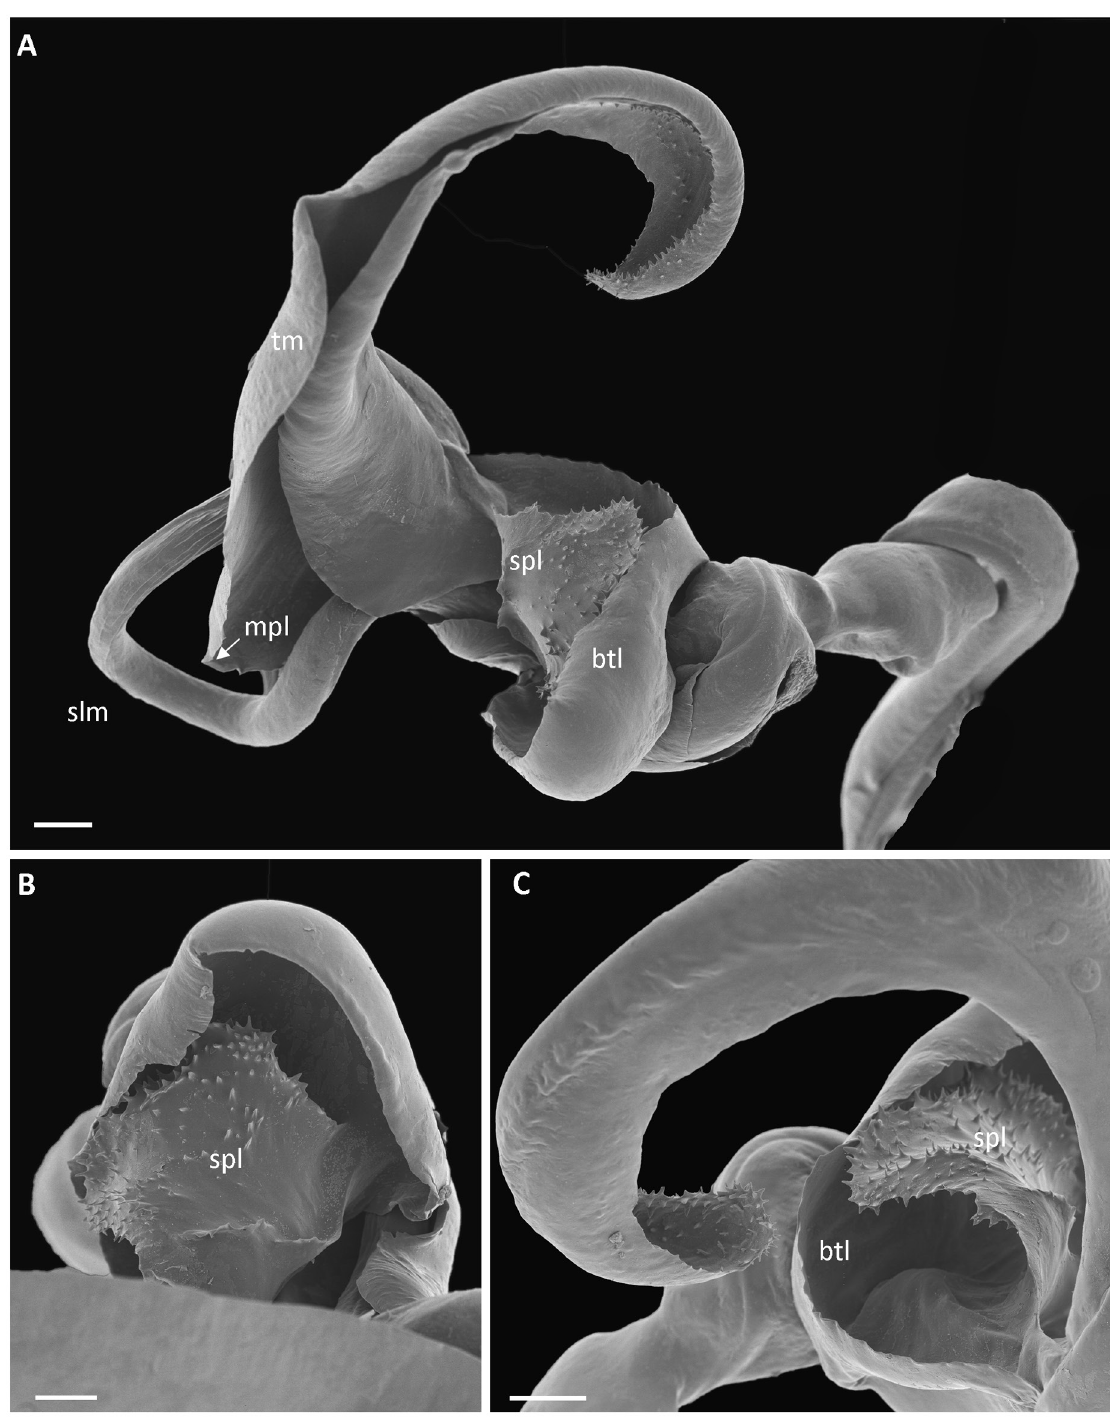
Fig. 17. Aquattuor udzungwensis Enghoff, 2015, male from Udzungwa Mts National Park, Kidatu (NHMD 621659), left gonopod telopodite. A . (Meso-)posterior view. B . Basal telomeral lamella, distal (ventral) view. C . Telomere, sublateral view. Abbreviations: btl = basal telomeral lamella; mpl = meso- posterior telomeral lamella, the arrow points to the diagnostic angle; slm = solenomere; spl = spinose lid-like flap; tm = telomere. Scale bars = 0.05